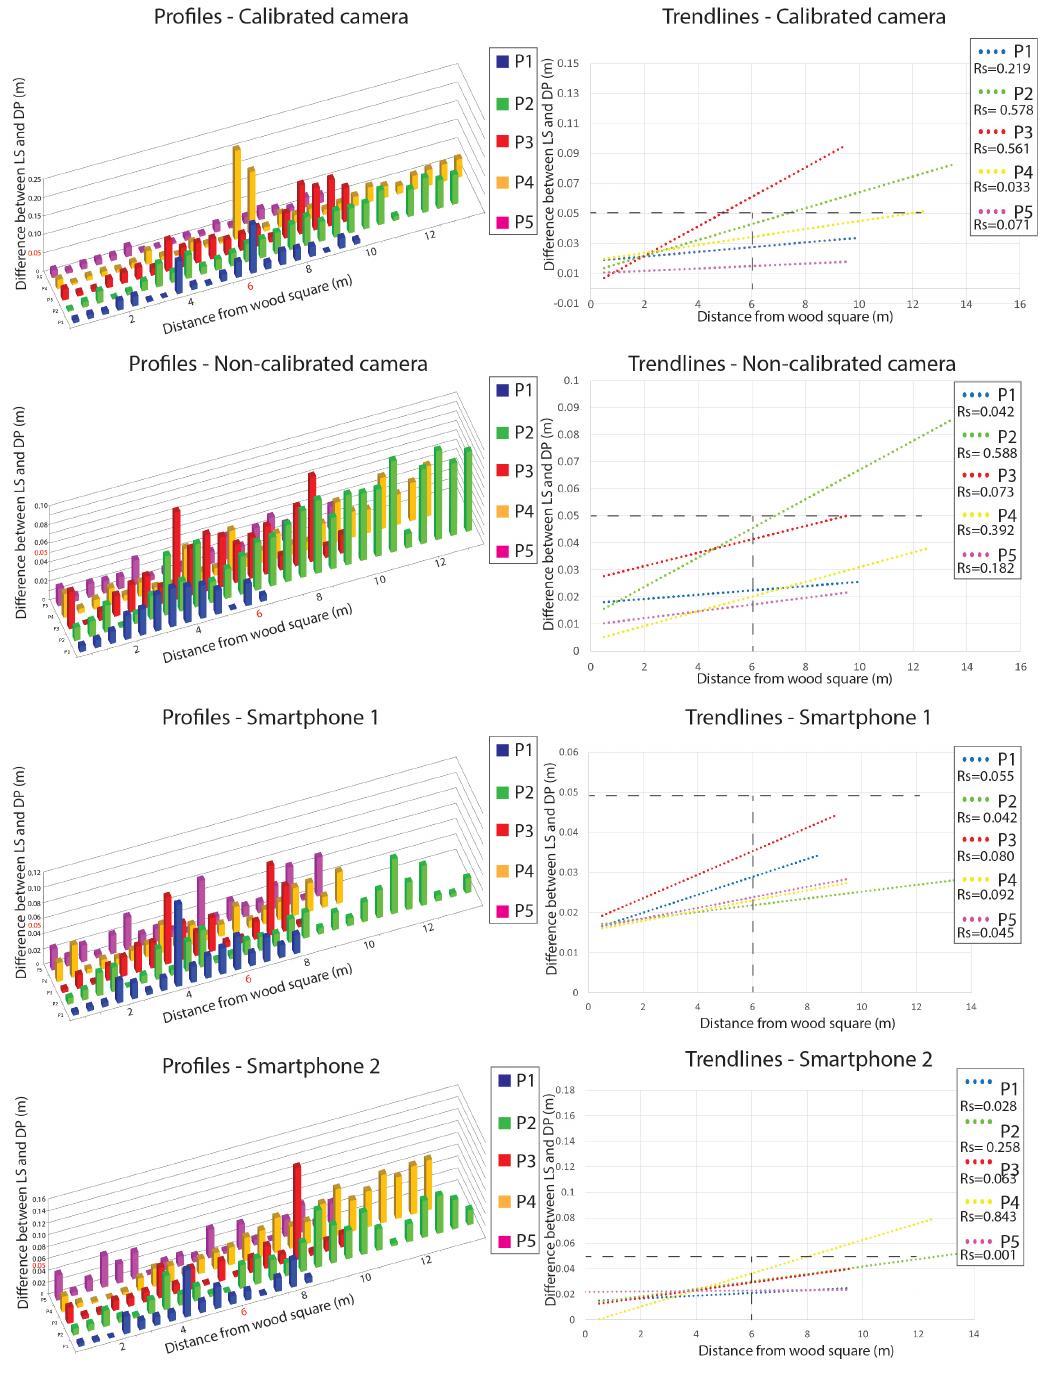
Figure 13. Dispersion graphs (left) and trendline graphs (right) obtained from comparison between the LS models and the calibrated camera, non-calibrated digital camera, smartphone 1 and smartphone 2 models. All models were georeferenced using the three targets 0, 5, and 3. For reference, we have included the black dashed lines in the trendline graphs at a distance of 6 m from the wooden square and for indicating a 0.05 m di ff erence between the LS and DP. In the column charts, 6 m of distance and 0.05 m of di ff erence were highlighted in red. Rs in the trendline graphs indicates the R square